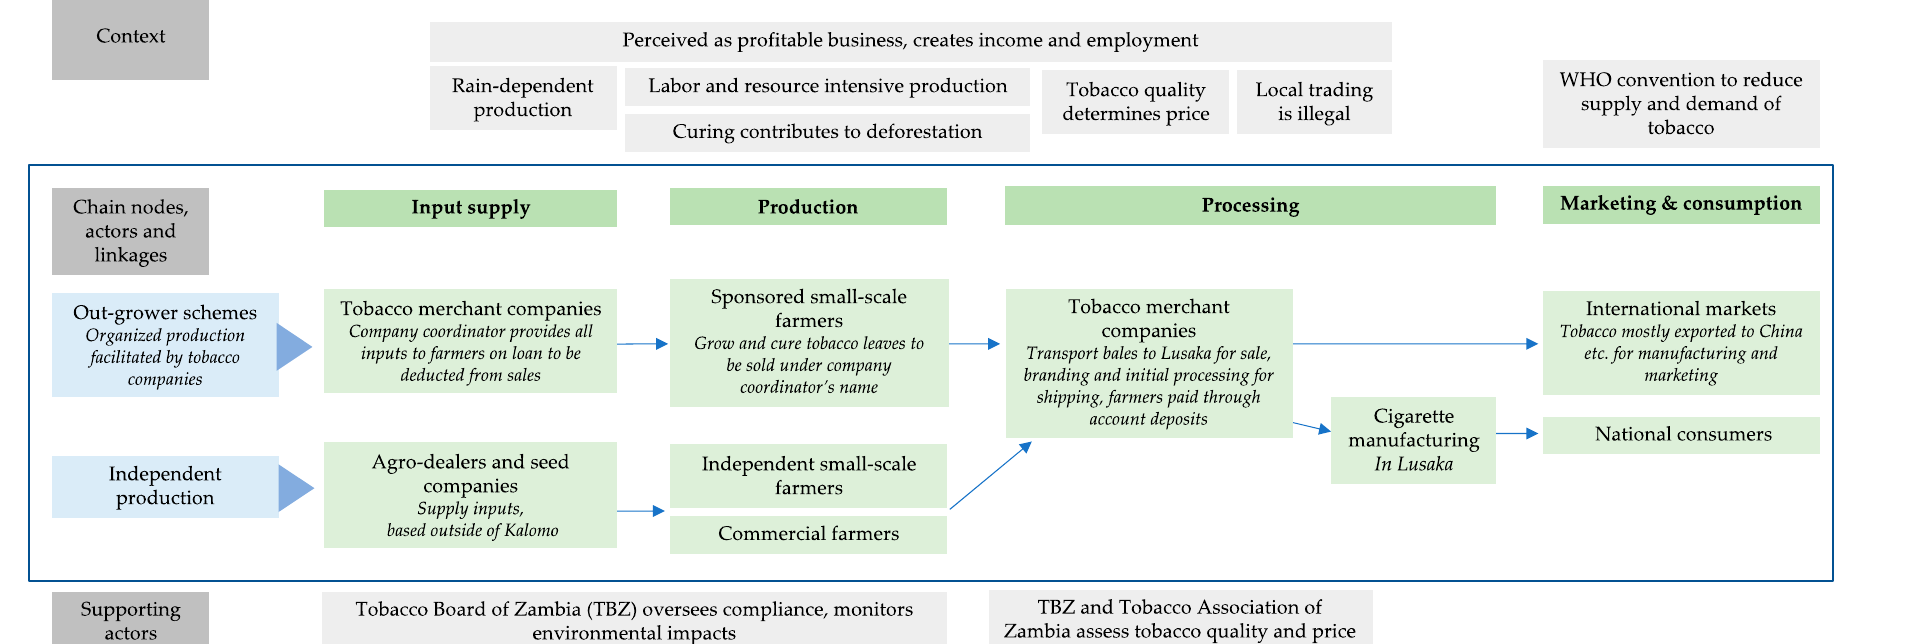
Figure 4. Tobacco value chain and context in Kalomo District (Source: Authors’ construct based on field research data).